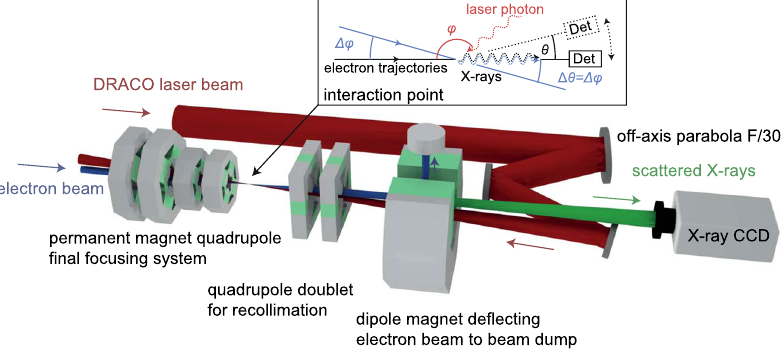
Figure 1. Schematic drawing of the interaction geometry. The electron beam (blue) is focused to the interaction point with a magnetic final focusing system. After interaction it is collimated again and deflected to a beam dump with a dipole magnet. The laser (red) is focused with an off-axis parabola (F/30). The interaction angle is close to head-on with a small angle of 22 mrad to have a clear path for the X-rays (green). The X-rays are detected with a CCD camera. Angles at the interaction point are illustrated in the schematic drawing of the